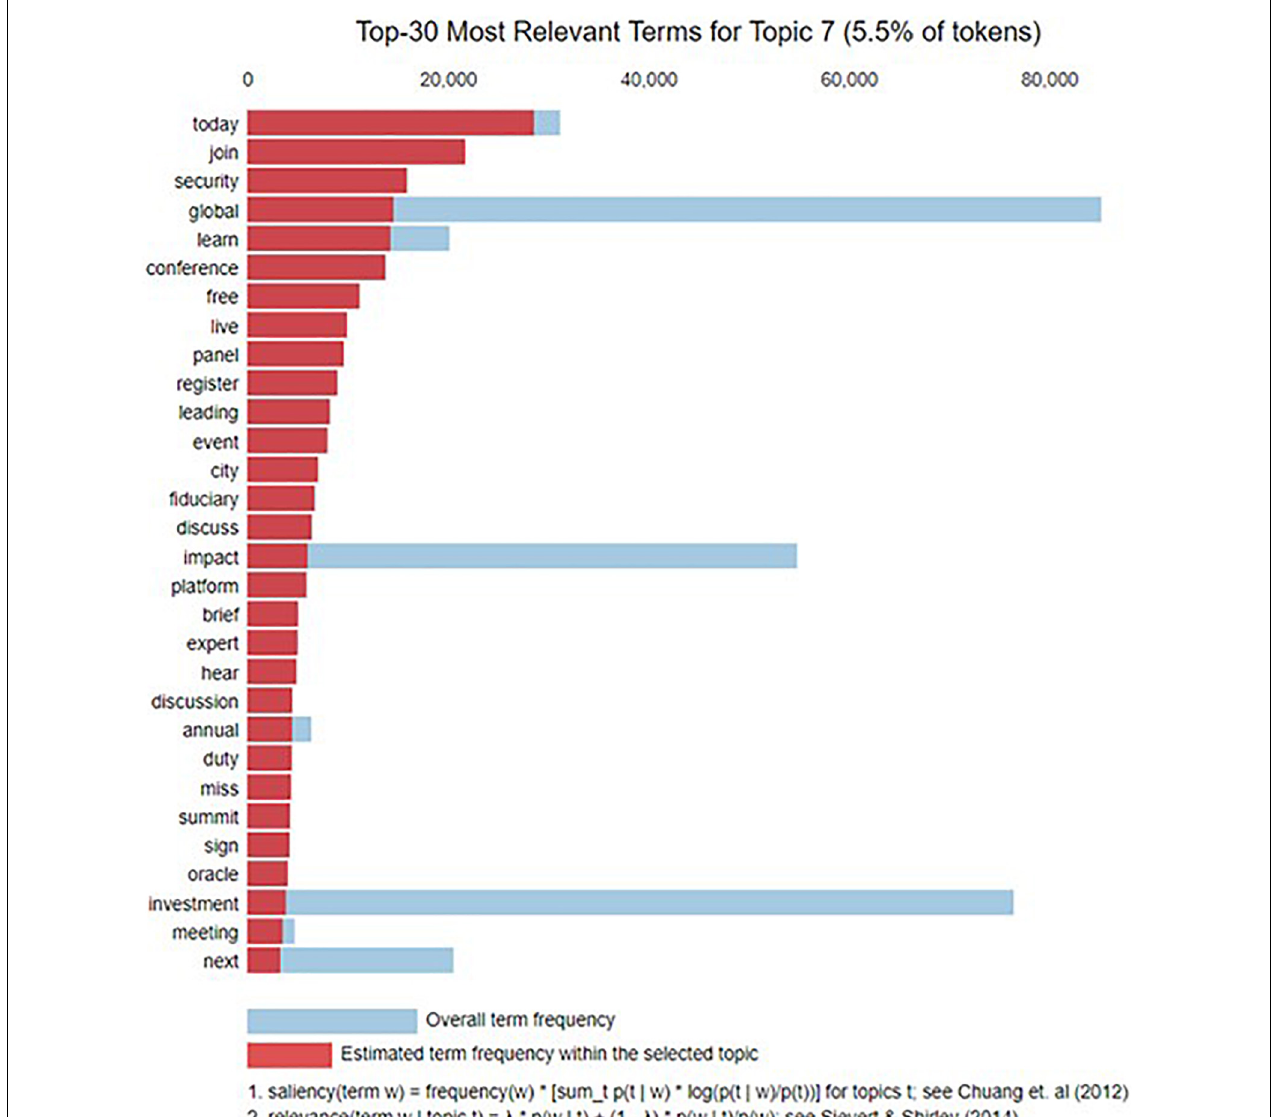
FIGURE 8 | Bar chart of the top 20 most frequently occurring terms for topic